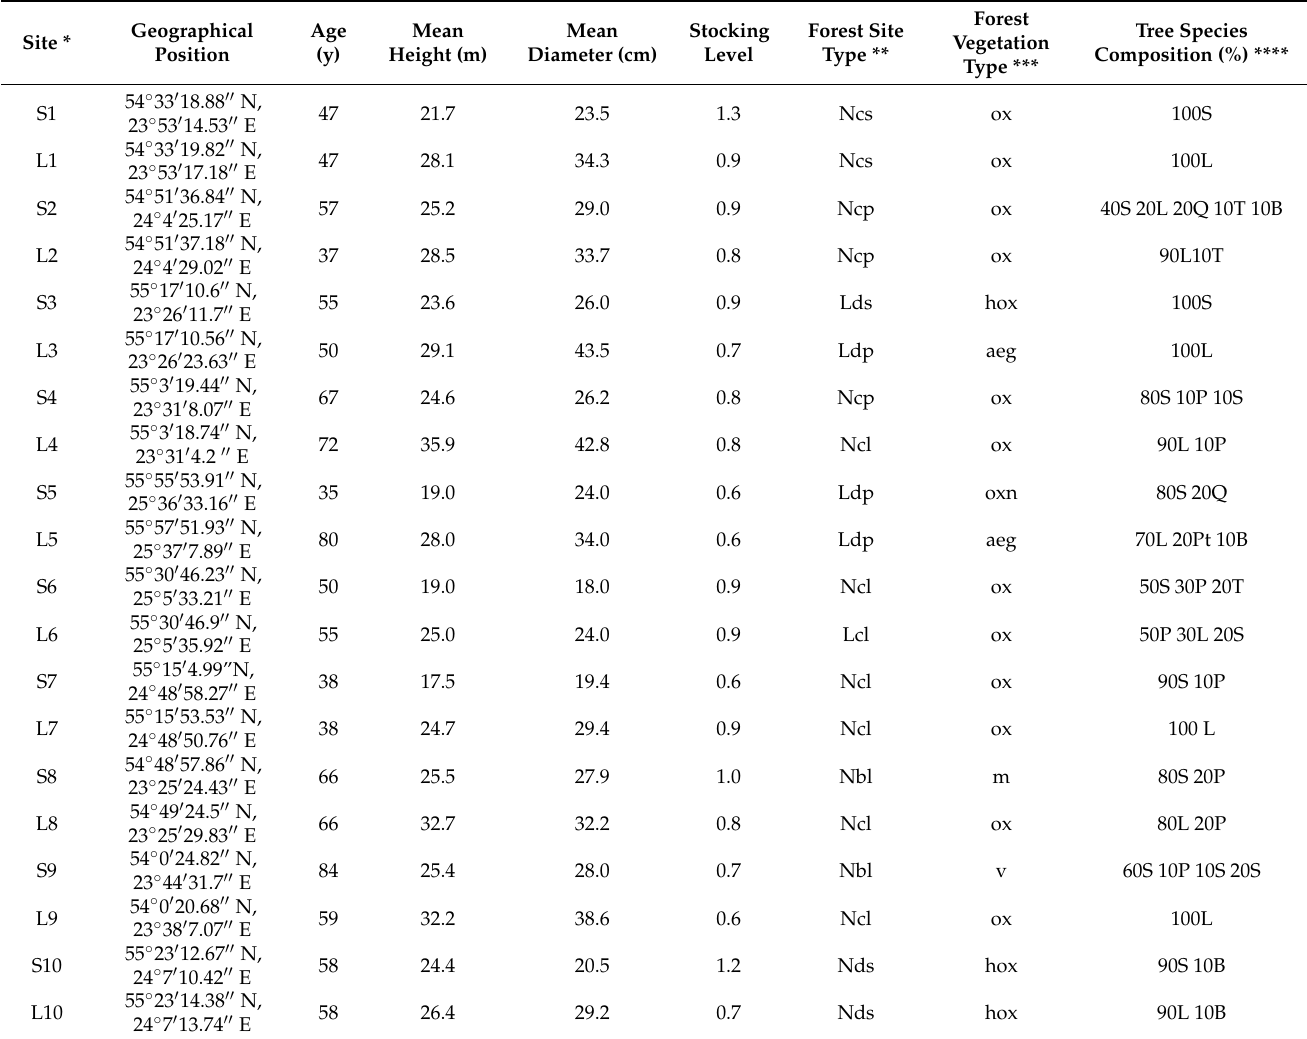
Table 1. Characteristics of investigated Picea abies and Larix sp. stands. Information is based on forest inventory data obtained from the State Forest Cadastre as of 1 December